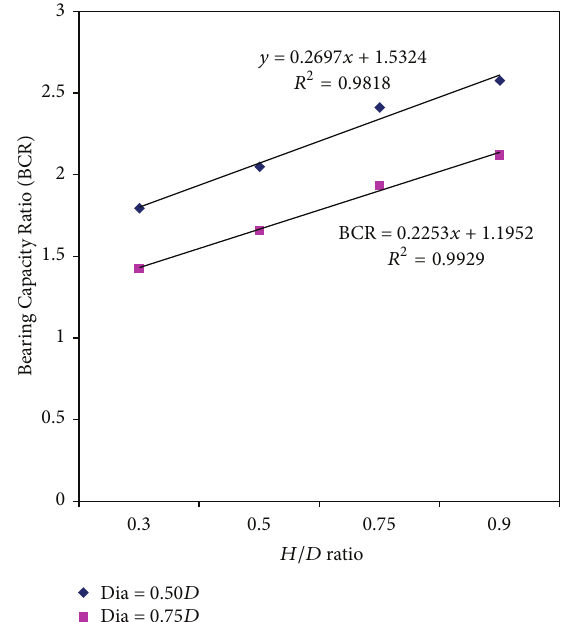
Figure 11: Bearing Capacity Ratio (BCR) for Series I, comparison. thickness was introduced in Series III. Compared to the RT- 0.50 𝑀 , test 0.50- 𝐺 (0.75 𝐷 ) increased its load bearing capacity by 30.21%, in similar manner test 0.75- 𝐺 (0.75 𝐷 ) increased its bearing capacity by 32.68% than that of RT-0.75 𝑀 .